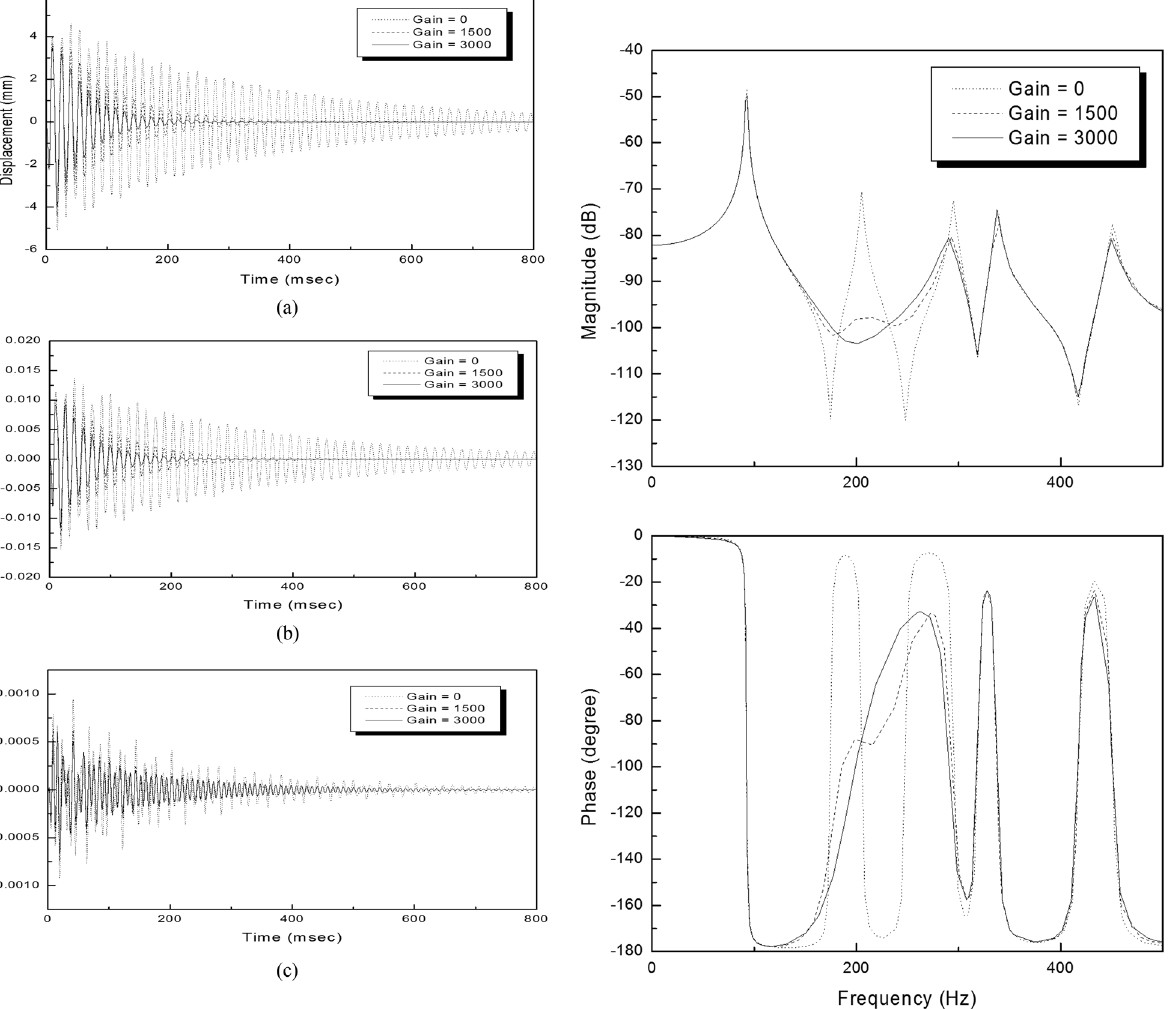
Figure 11: Frequency response of the shear - web case 2 due to a di ff erent feedback control gain.